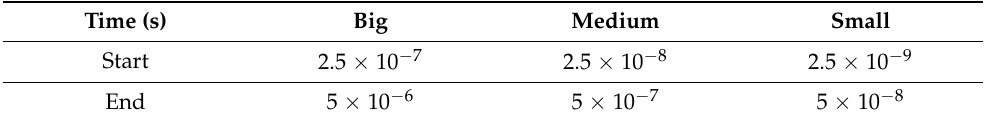
Table 5. Time steps for time independence